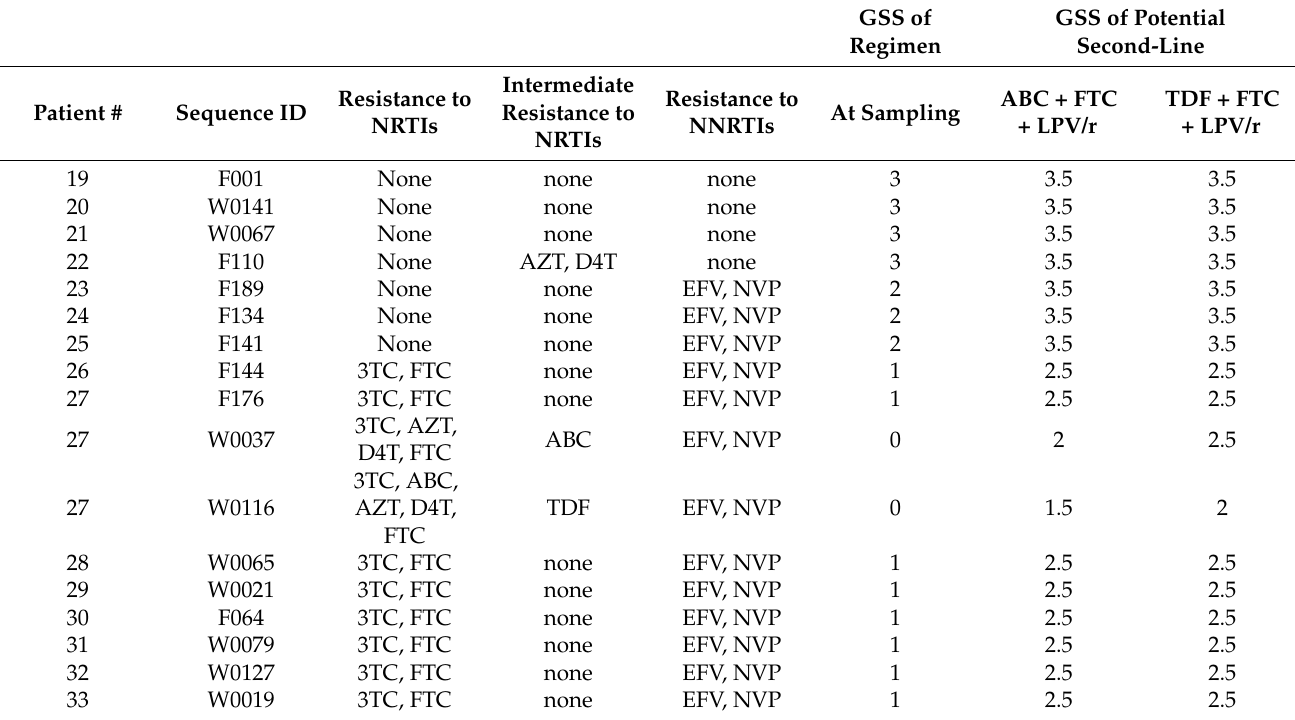
Table 4. Genotypic susceptibility score. Genotypic susceptibility of the current regimen and expected second-line regimen in genotypes from cART-experienced patients.